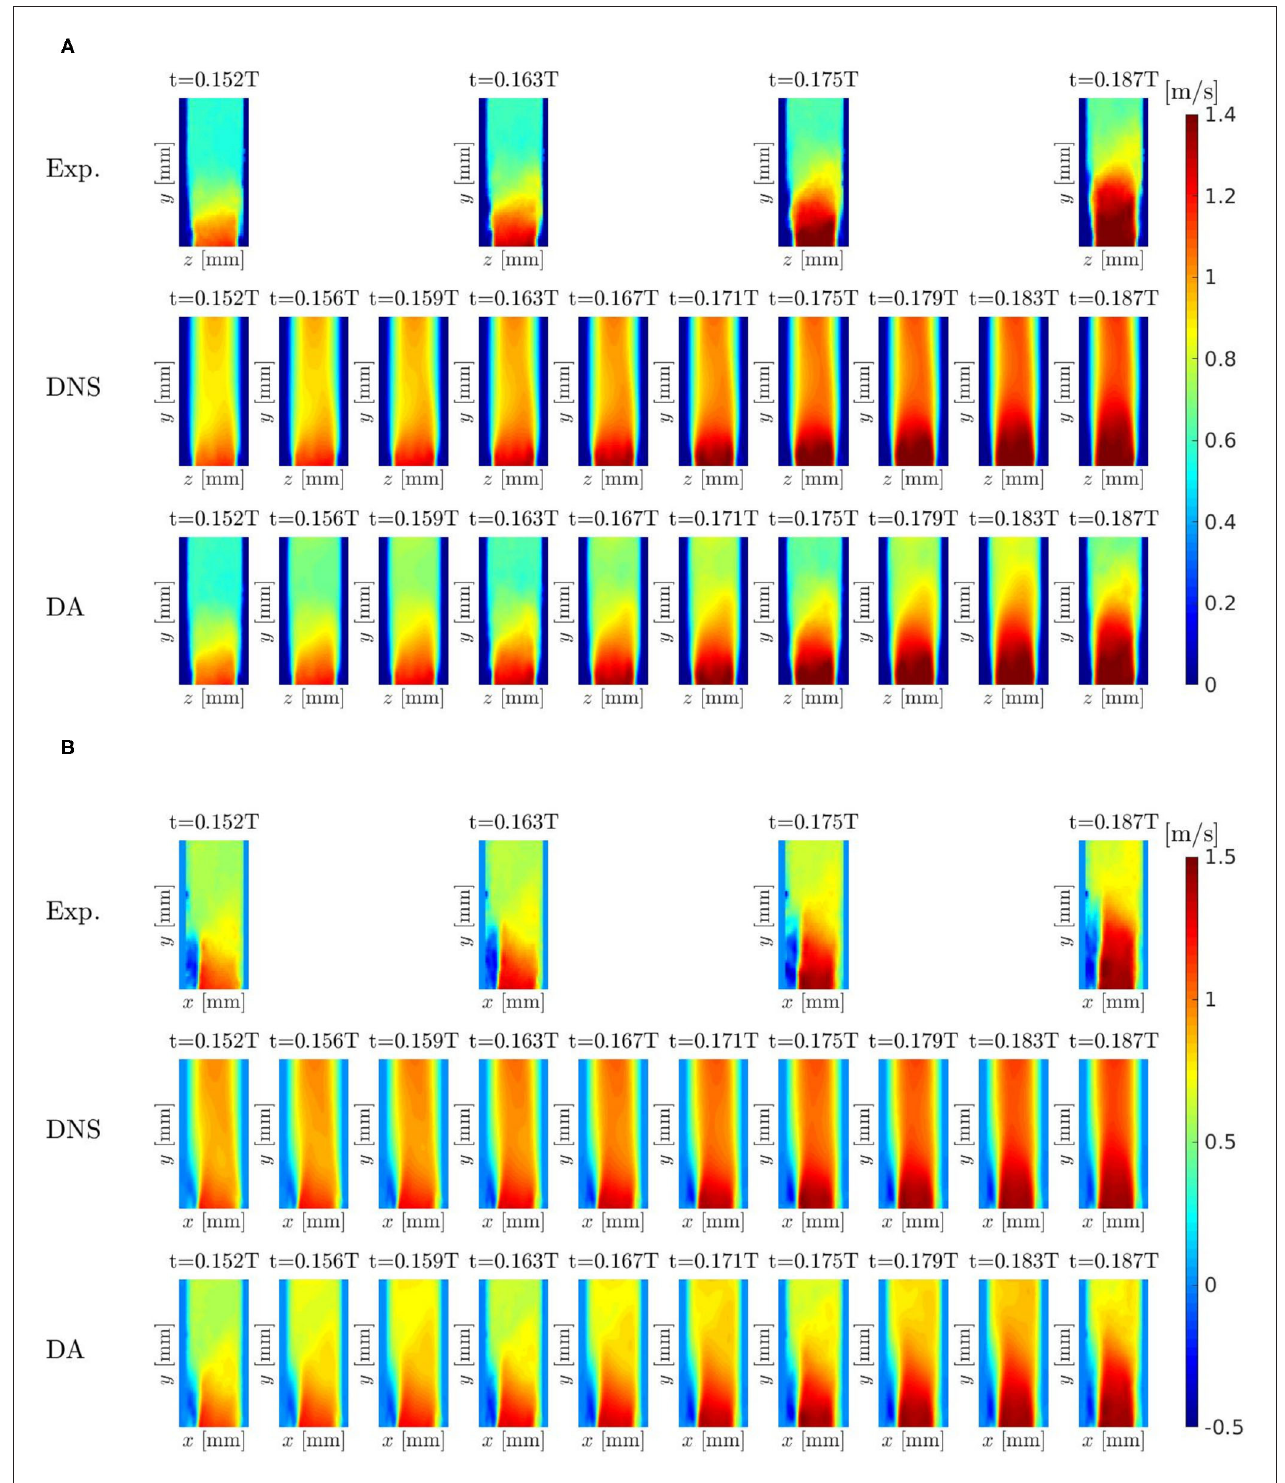
FIGURE 13 | Pulsatile turbulent flow downstream of a transcatheter aortic valve: comparison between experiments, DNS, and DA prediction of velocity field E x , t φ h u y i φ for x = 0 (A) and for z = 0 (B) . (cid:0) (cid:1)